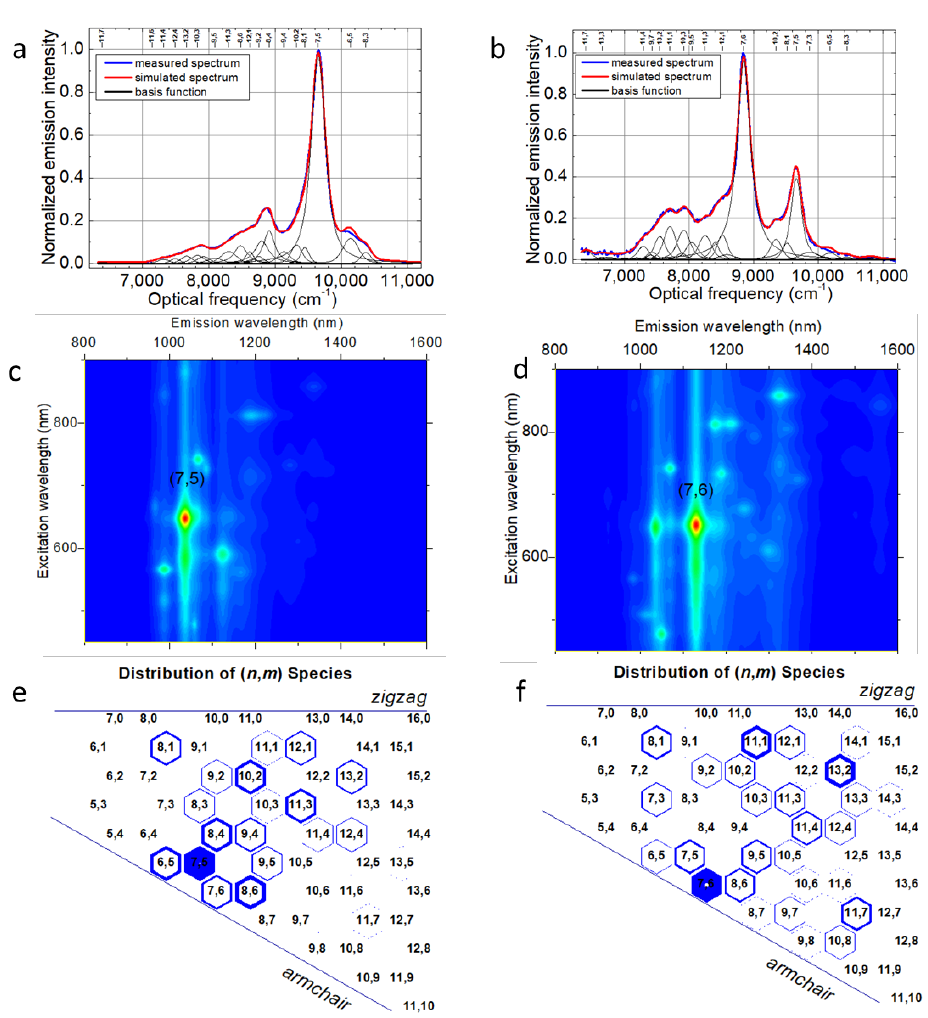
Figure 1. Measured and simulated fluorescence spectra of separated ( a ) (7,5), ( b ) (7,6) chiral single-walled carbon nanotubes (SWCNTs). The corresponding generated photoluminescence–excitation contour plot of ( c ) (7,5), ( d ) (7,6) sorted fractions. Graphene sheet representing the distribution of the emissive species in the respective ( e ) (7,5) and ( f ) (7,6) enriched sorted SWCNT samples. The blue-filled portion of hexagons represent the relative abundance of the species.